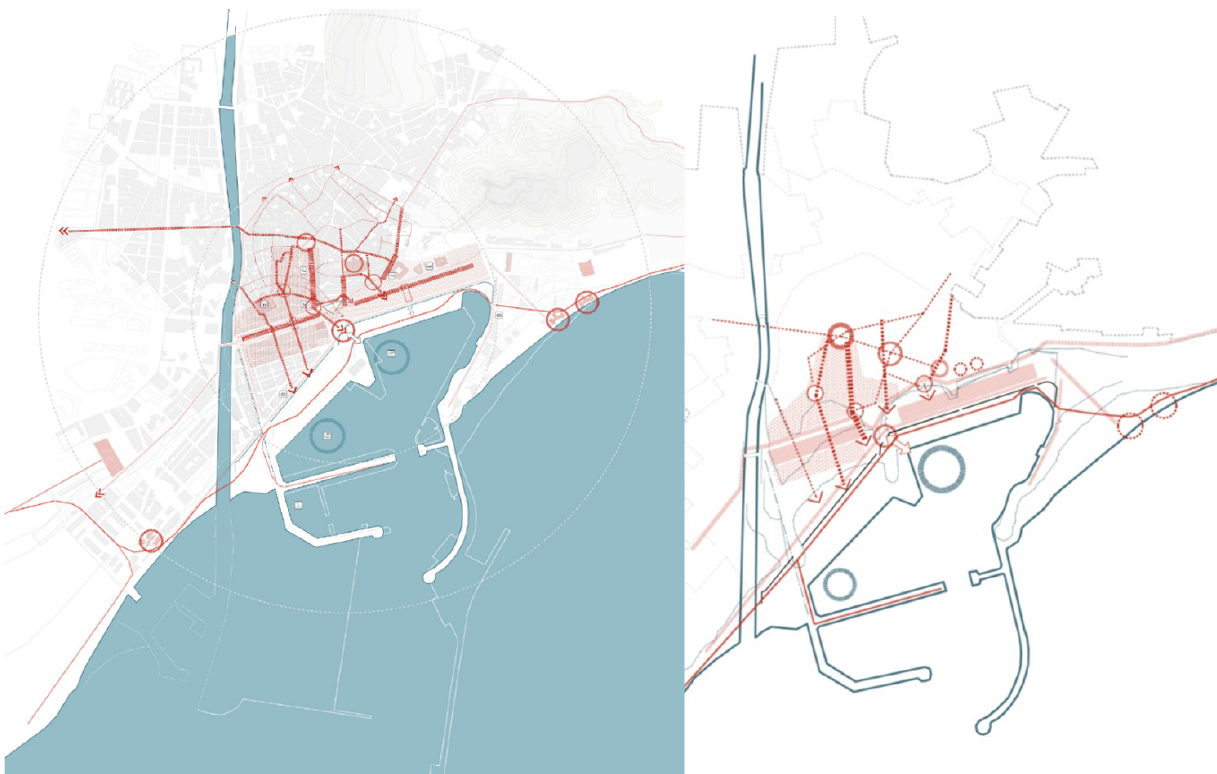
Figure 6. Study of the port city of Malaga’s configuration around different physical, functional, and social factors (19th cen‐ tury): The port closes in on itself, separated from the city by fencing, roads, and railway lines, and from the sea by the narrowing of the harbour mouth. Source: María J. Andrade